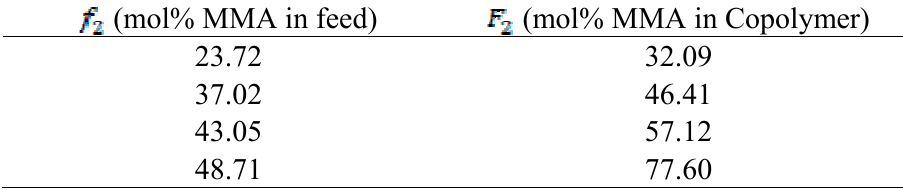
Table 5. EGDMA/MMA copolymer analysis by IR Spectroscopy (IV).